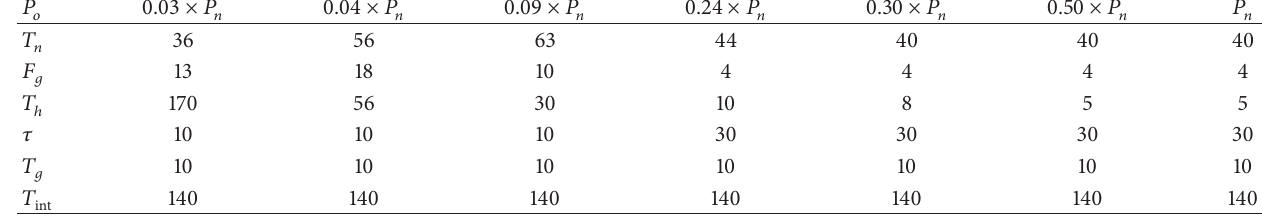
Table 1: Parameters of the UTSG model at different power levels [27].